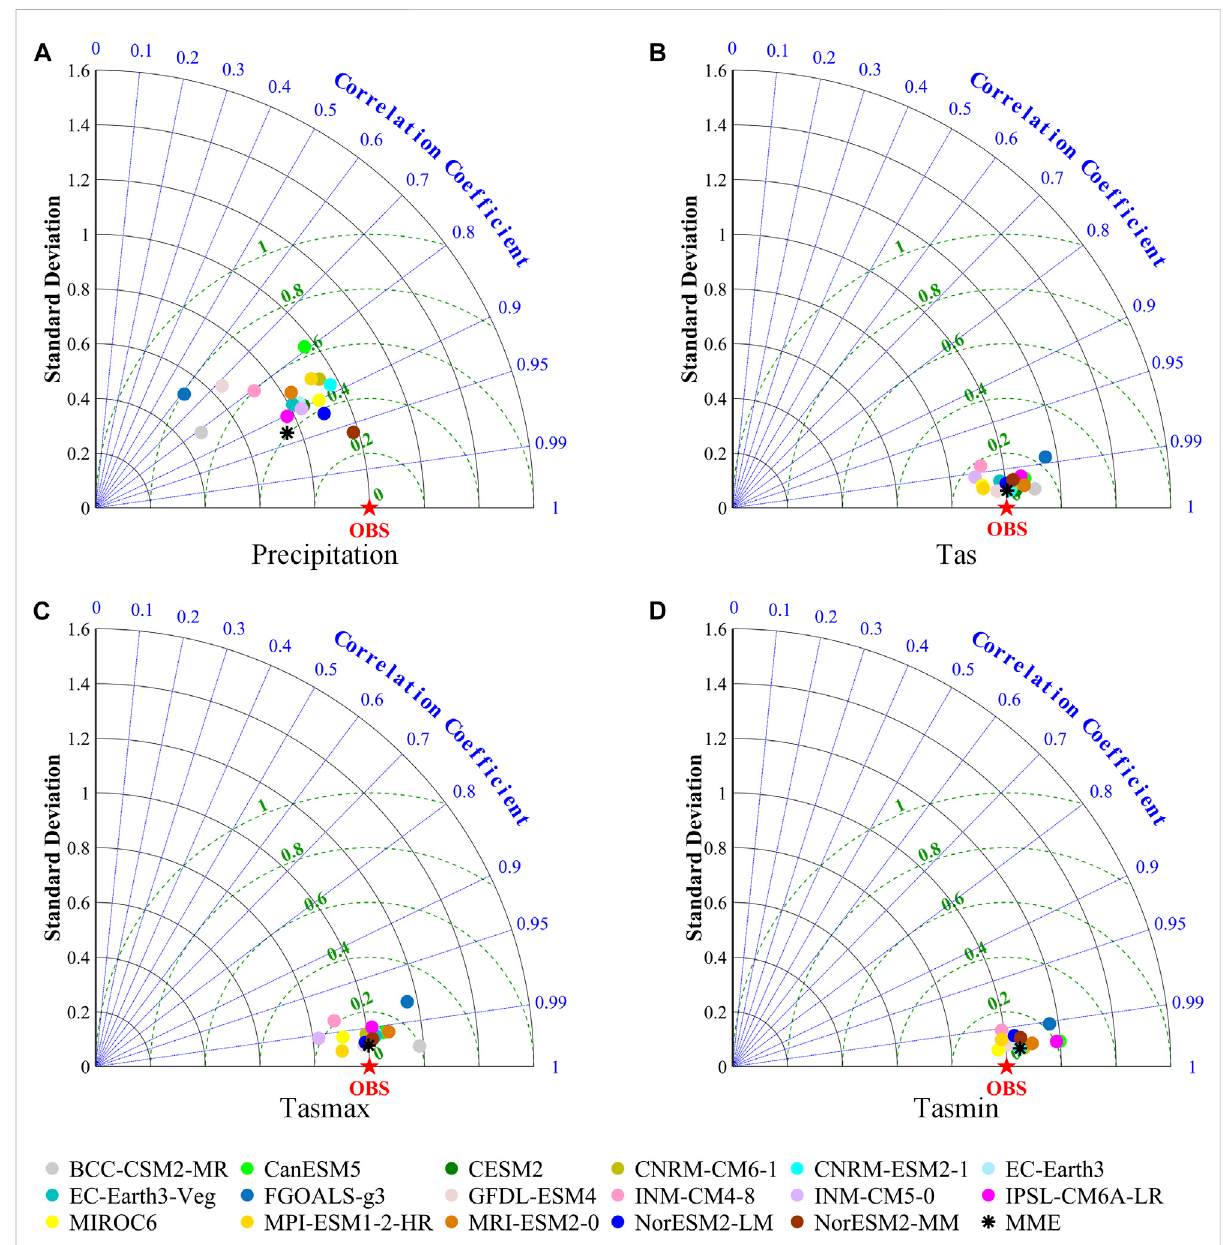
FIGURE 2 Taylor diagrams for precipitation and temperature by CMIP6 of the PLB. (A – D) are the precipitation, Tas, Tasmax and Tasmin of the